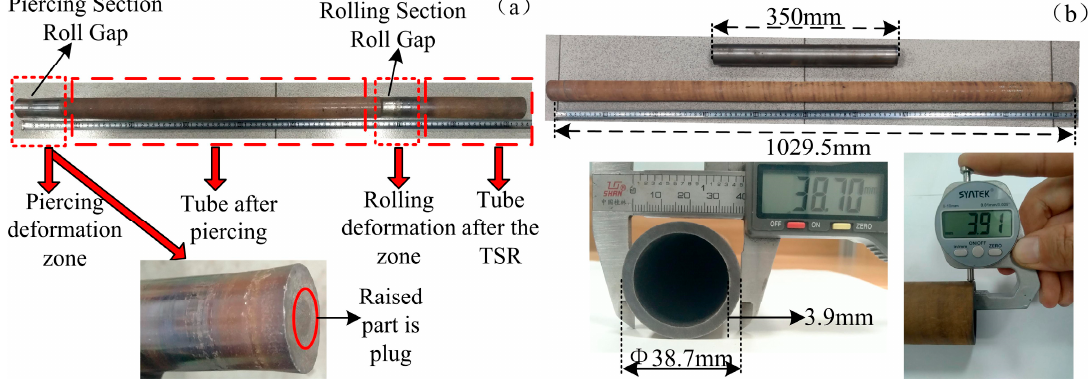
Figure 10. Rolling force detection: ( a ) rolling force acquisition system; ( b ) rolling force curve.